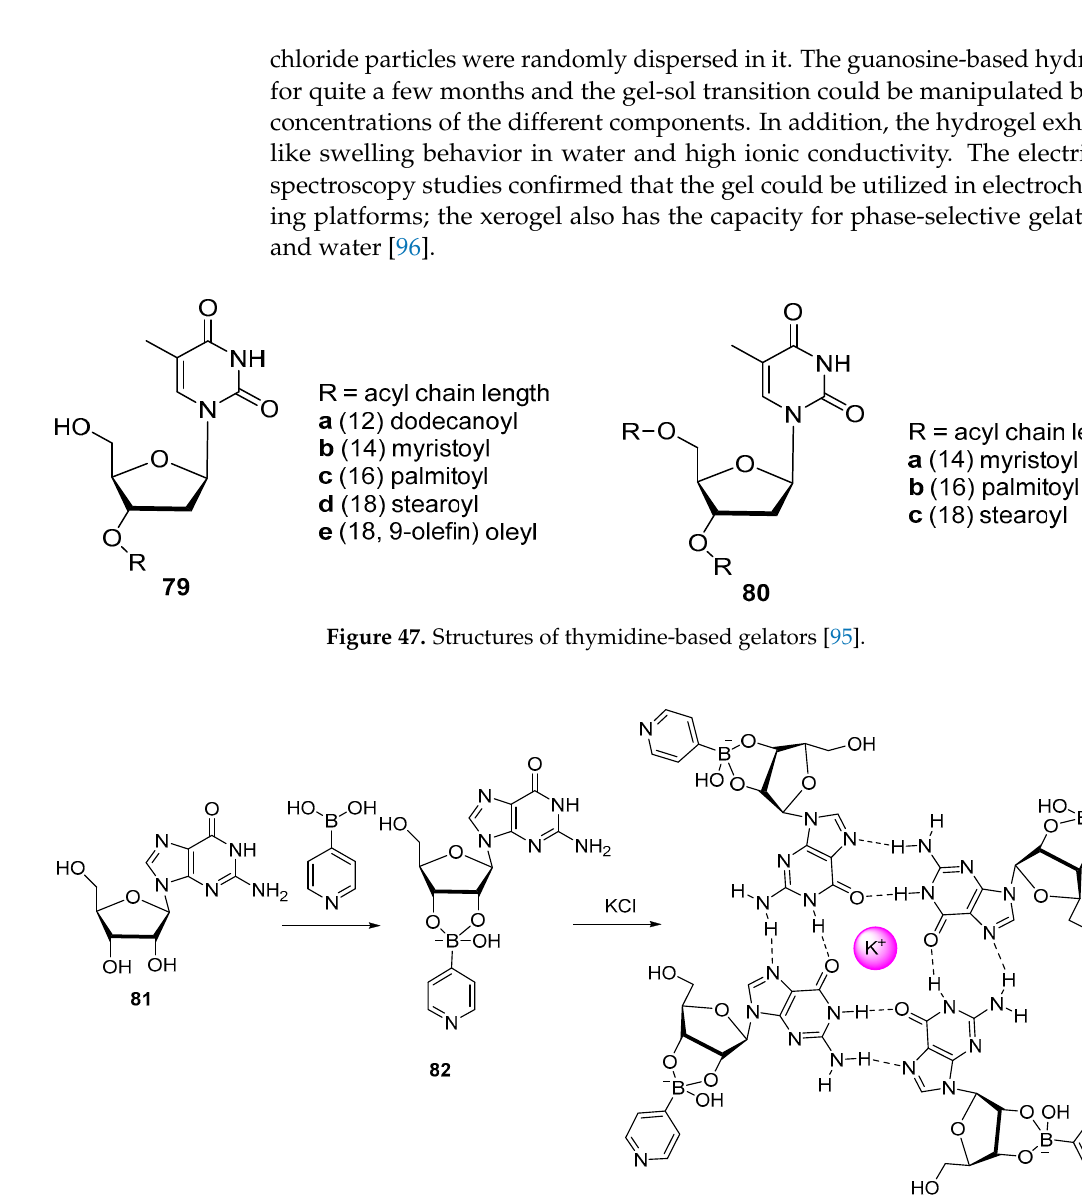
Figure 48. Guanosine monophosphate and the self-assembled G-quadruplex with Ca 2+